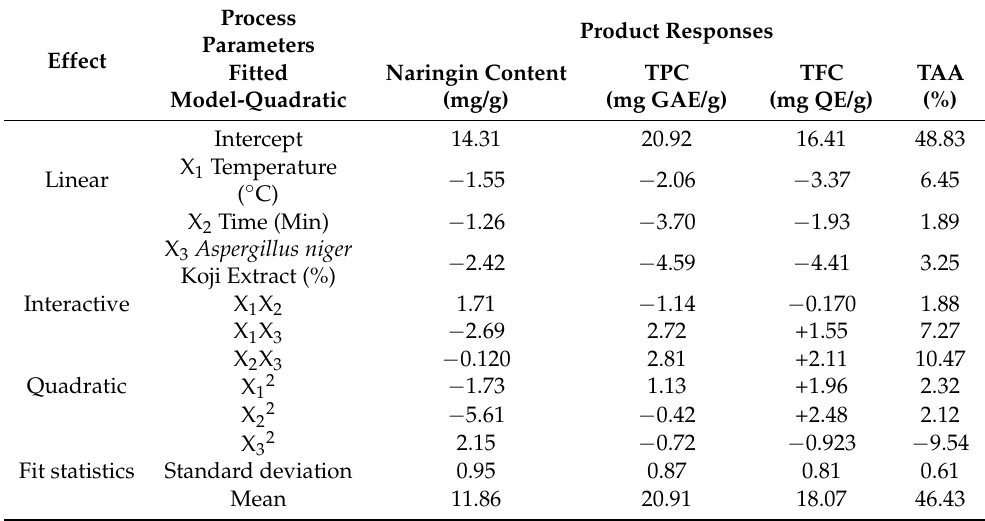
Table 4. Coefficients of regression analysis for independent process parameters and product